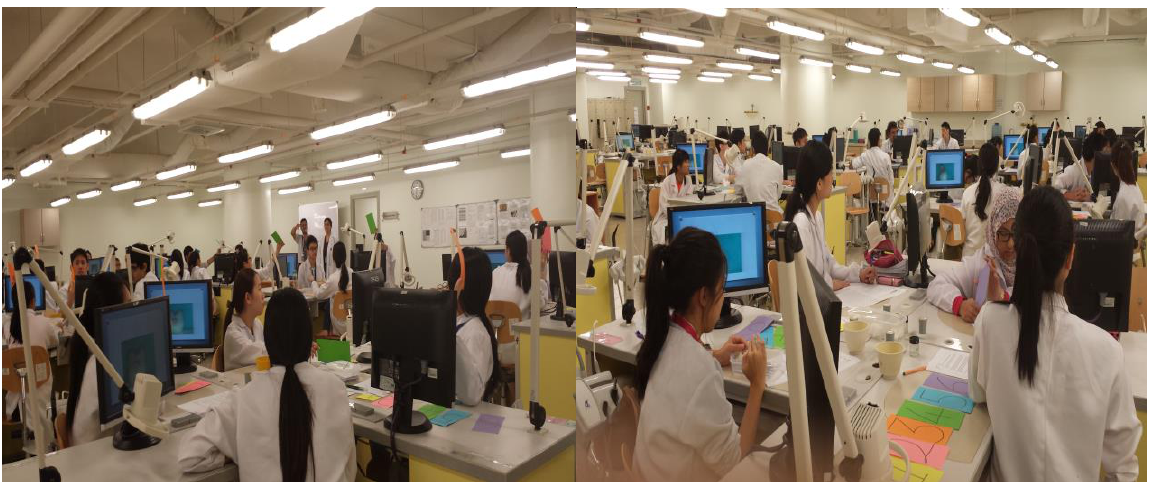
Figure 6. Student Training Workshop: Photo discussion session.